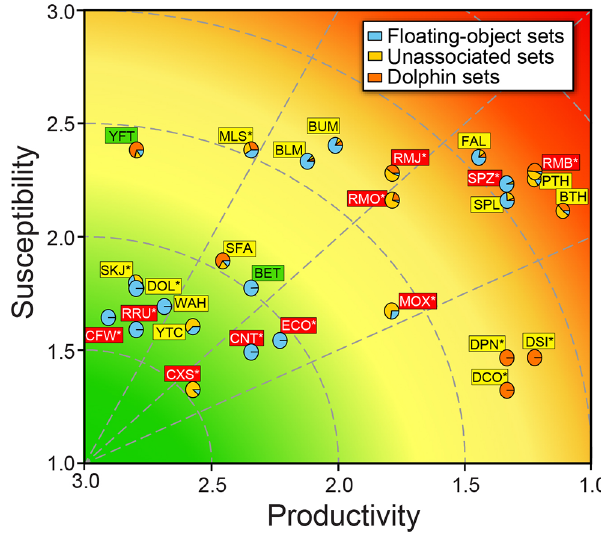
Fig. 1. Scatterplot depicting results of the productivity-susceptibility analysis (PSA) for the purse-seine fi shery in the eastern Paci fi c Ocean. Vulnerability ( v ) isopleths (dashed lines) with values of 0.5, 1.0, 1.5, 2.0 de fi ne the boundaries of “ low ” ( v (cid:1) 1.0, green), “ moderate ” (1 < v < 2, yellow), and “ high ” ( v ≥ 2.0, red) relative vulnerability. The proportion contribution by each species to the catch by purse-seine set type is displayed in the pie charts. Coloured boxes represent mean data quality (DQ) score: green =high (DQ < 2), yellow = moderate (3 < DQ ≥ 2), red =low (DQ ≥ 3). Figure and caption from Duffy et al. (2019). Species codes are de fi ned in Table 3. (For interpretation of the references to colour in this fi gure legend, the reader is referred to the web version of this